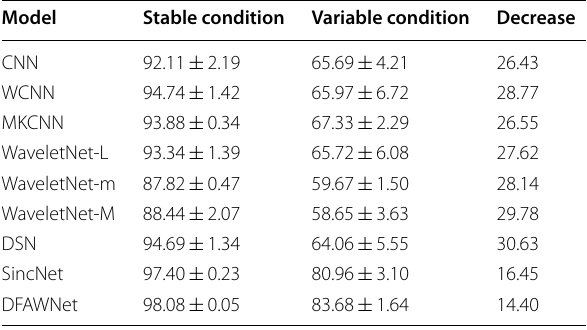
Table 4 Average accuracy (%) with different operating